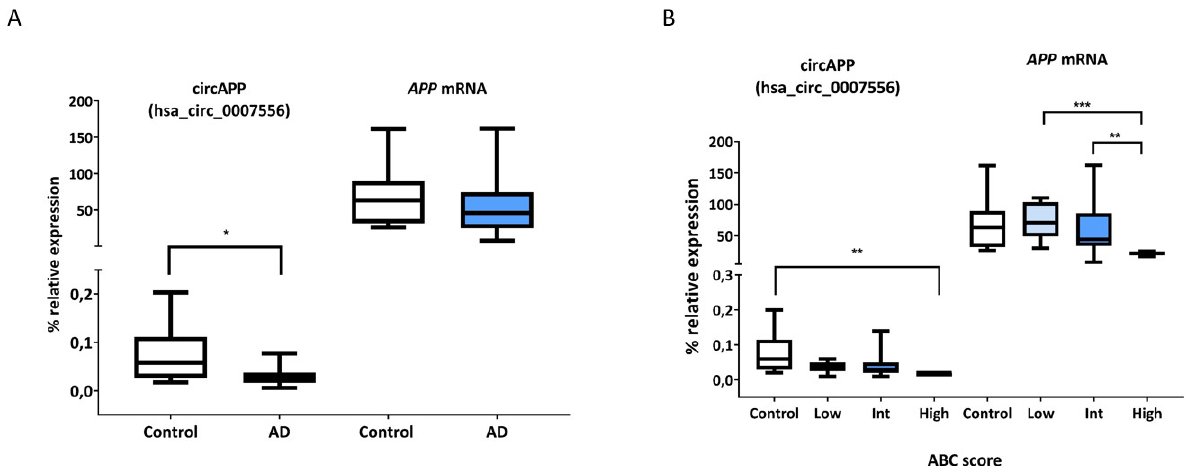
Figure 2. Expression of circAPP (hsa_circ_0007556) and APP mRNA and as a function of the ABC score. ( A ) The box-plot represents the percentage of relative expression of circAPP (hsa_circ_0007556) and APP mRNA in patients and controls with respect to the geometric mean of the housekeeping genes GAPDH and ACTB . ( B ) The box-plot represents the percentage of the relative expression of circAPP (hsa_circ_0007556) and APP mRNA according to the ABC score groups, with respect to the geometric mean of the housekeeping genes GAPDH and ACTB . * p -value < 0.05, ** p -value < 0.01 and *** p -value < 0.001.